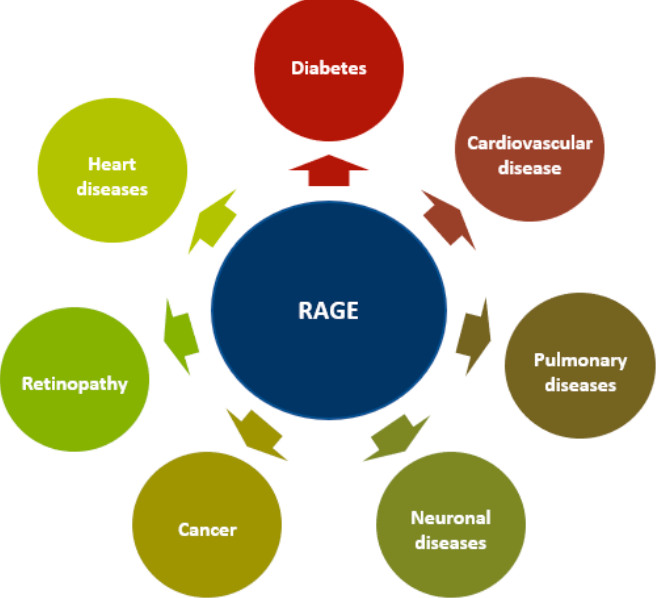
Figure 3. RAGE in different diseases. The overexpression and activation of RAGE are hallmarks of various diseases including neurodegenerative, cardiovascular, pulmonary and heart diseases, atherosclerosis, diabetes, retinopathy, and cancer.